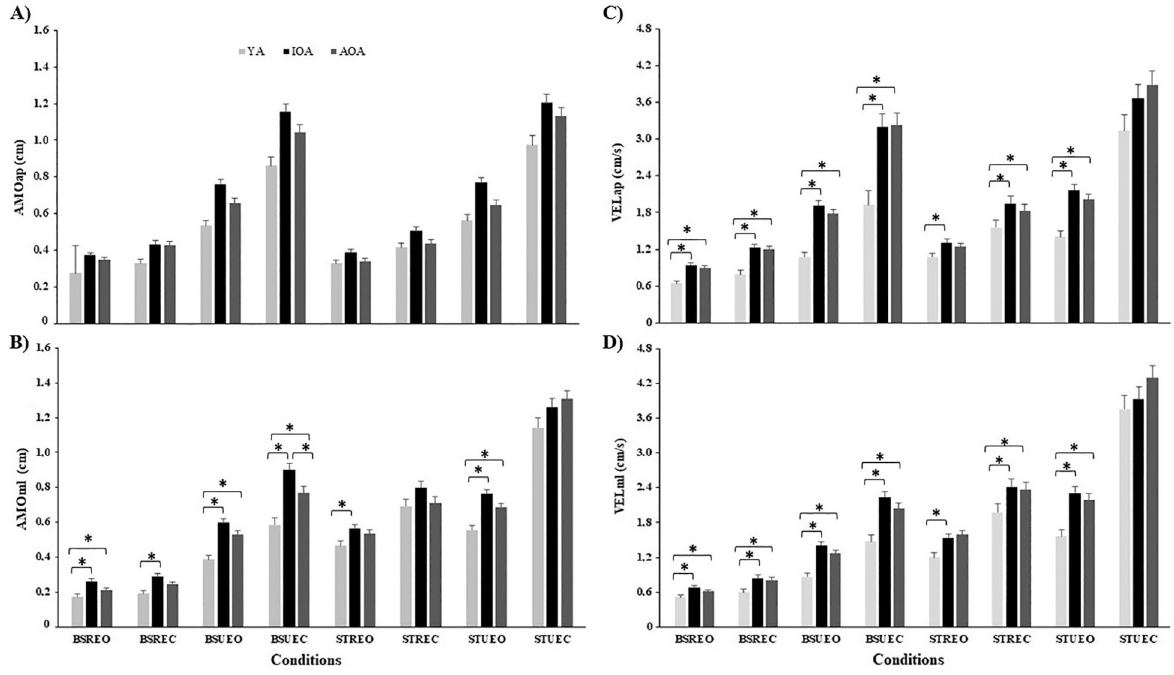
Figure 1 - Mean and standard deviation of the MSA_AP (A), MSA_ML (B), VEL_AP (C), and VEL_ML (D) variables for the YA, AOA, and IOA groups under